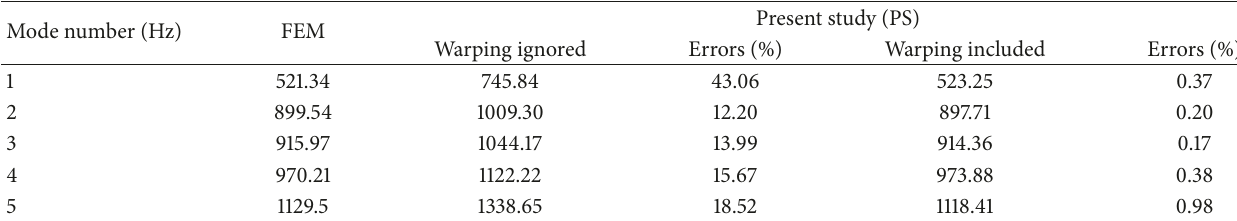
Table 1: The first five frequencies of Beam 1 (made of isotropic material).